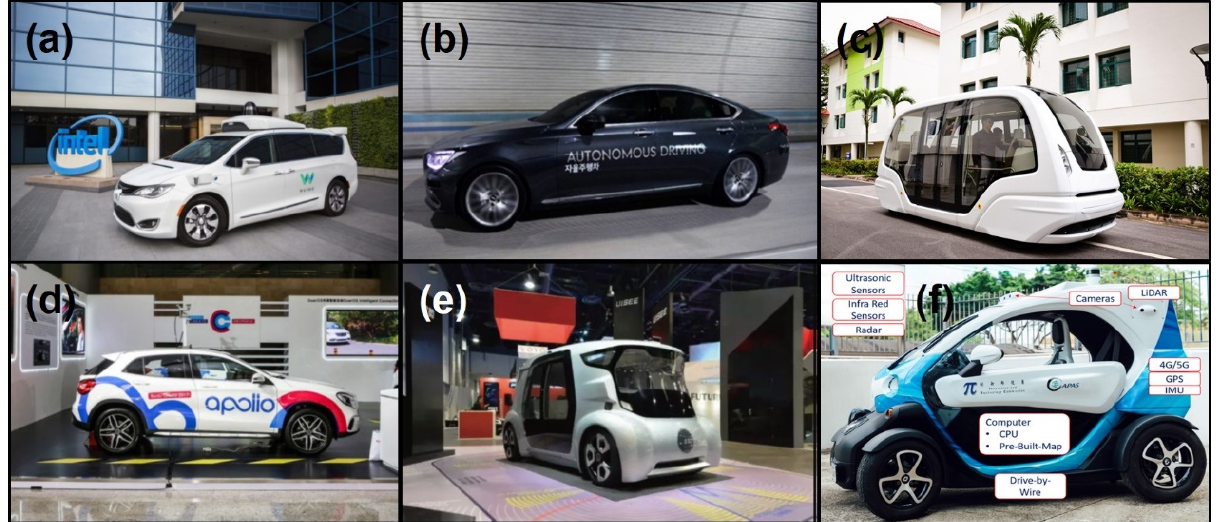
Figure 10. Representative autonomous vehicles around the world: ( a ) Waymo autonomous vehicle [152]; ( b ) Hyundai autonomous vehicle tested in “K-City” [153]; ( c ) Autonomous shuttle at Nanyang Technological University [154]; ( d ) Baidu autonomous vehicle [155]; ( e ) UISEE autonomous vehicle [156]; ( f ) Autonomous shuttle developed by APAS and HKPC.